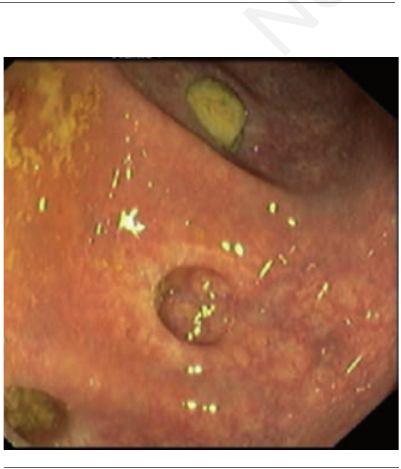
Figure 2. Photography from colonoscopy showing stenosis and ulceration at the enterocolic